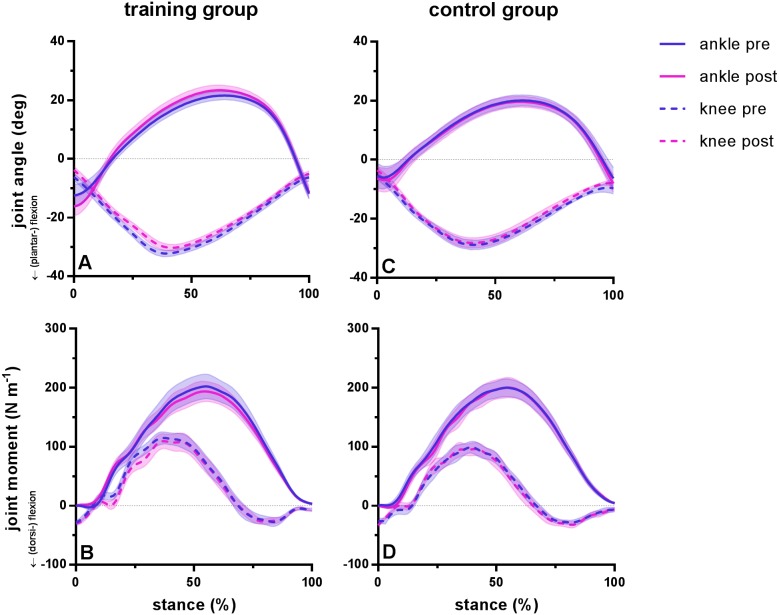
Group mean ankle and knee joint angles and moments during the stance phase of barefoot running at preferred speed for the training group (A–B) and the control group (C–D).Time series are normalized to 101 points. Values are means ± s.e.m.